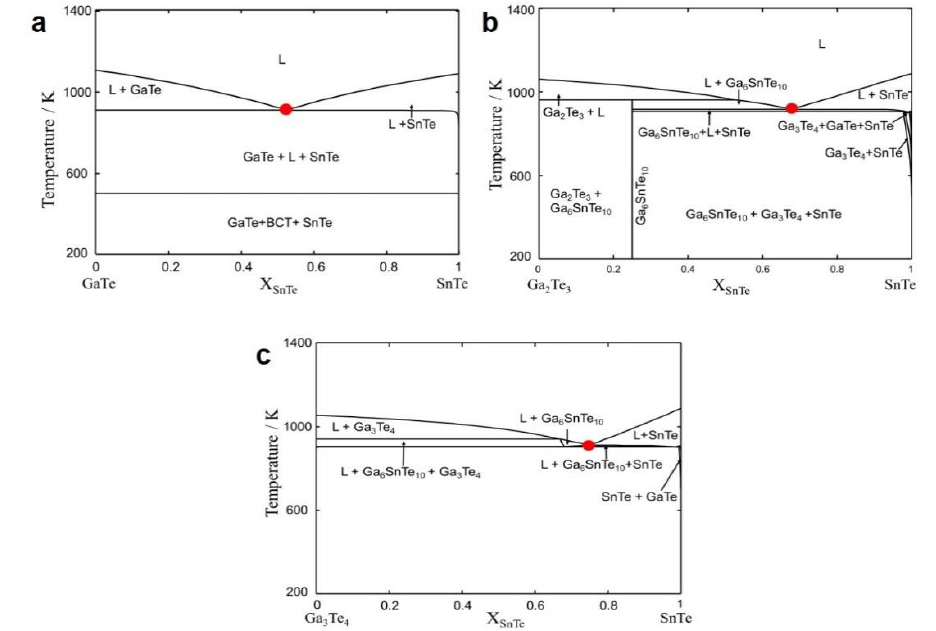
Figure 10. Calculated vertical section of ( a ) GaTe-SnTe, ( b ) Ga 2 Te 3 -SnTe, and ( c ) SnTe-Ga 3 Te 4 quasi-binaries.